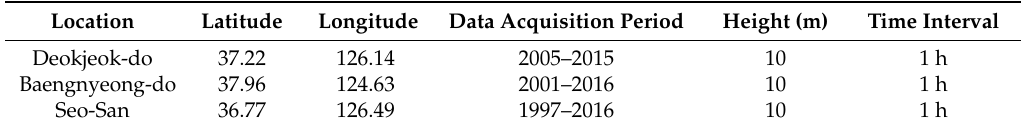
Table 1. Information about the metrological